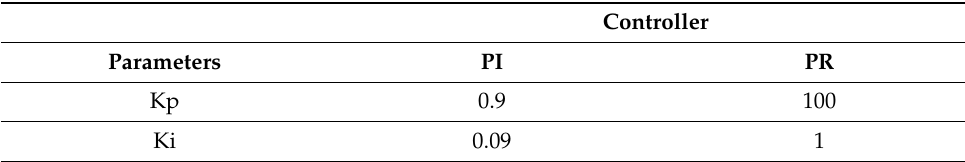
Table 3. Parameters of voltage regulators.